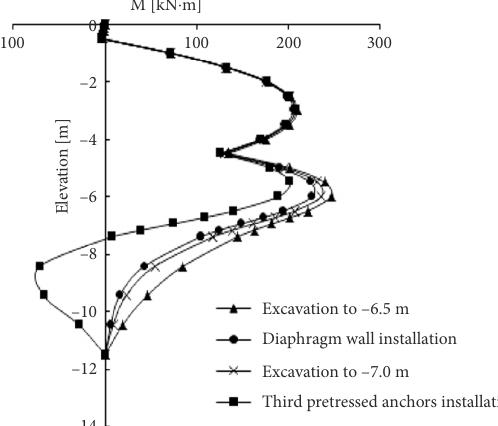
Figure 8. Evolution characteristics of cast-in-situ pile moment during excavation to –6.5 m and –7.0 m